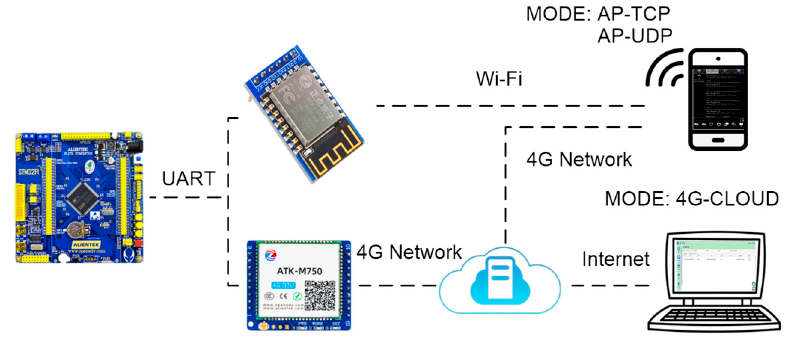
Figure 7. LWCS connection architecture.